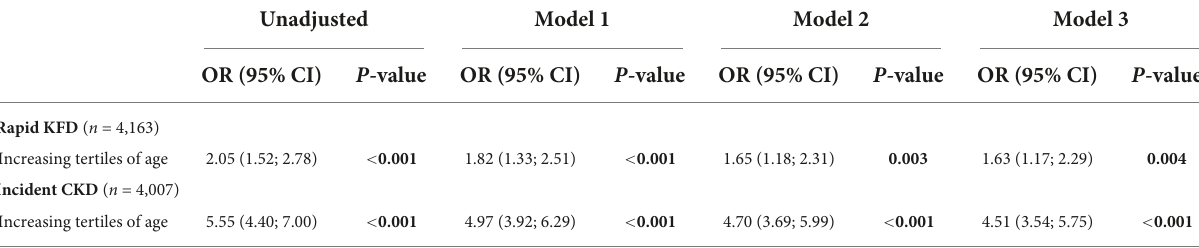
TABLE 3 Logistic regression using tertiles of age as a predictor of rapid kidney function decline or incident chronic kidney